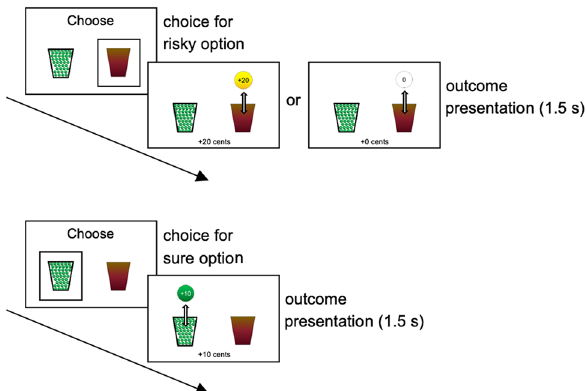
Figure 1. Trial outline in case of a risky (upper plot) and sure (lower plot) choice. This figure was created using Microsoft PowerPoint 16.16.27, https:// www. micro soft. com/ en- us/ micro soft- 365/ power